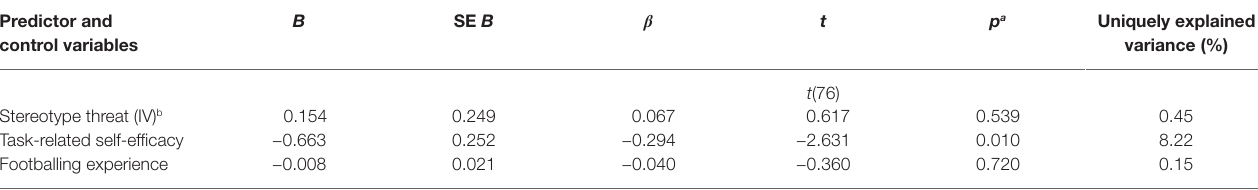
TABLE 3 | Regression analysis with mistakes as criterion. Predictor and control variables